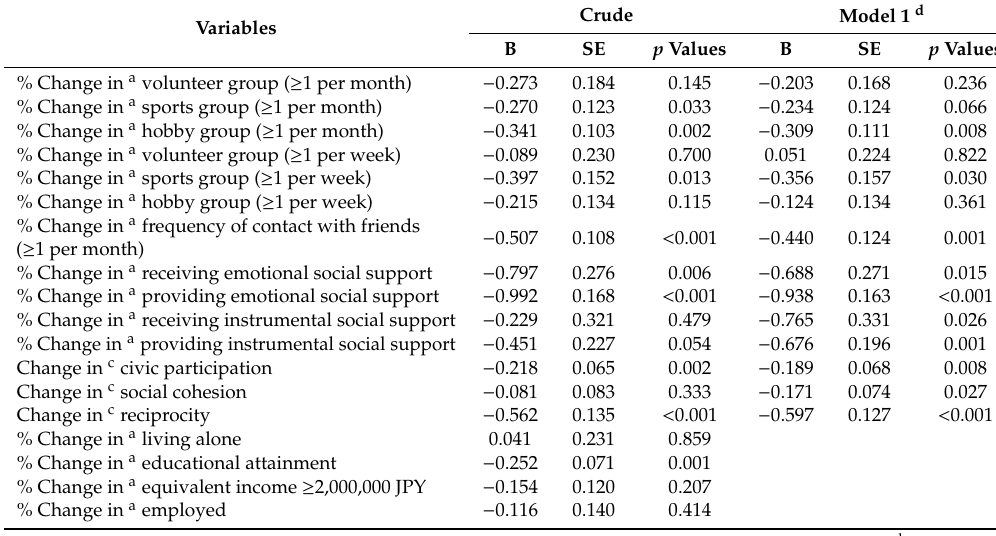
Table 2. Multiple linear regression of changes in a health-related social capital (SC) with changes in depressive symptoms b ( n =